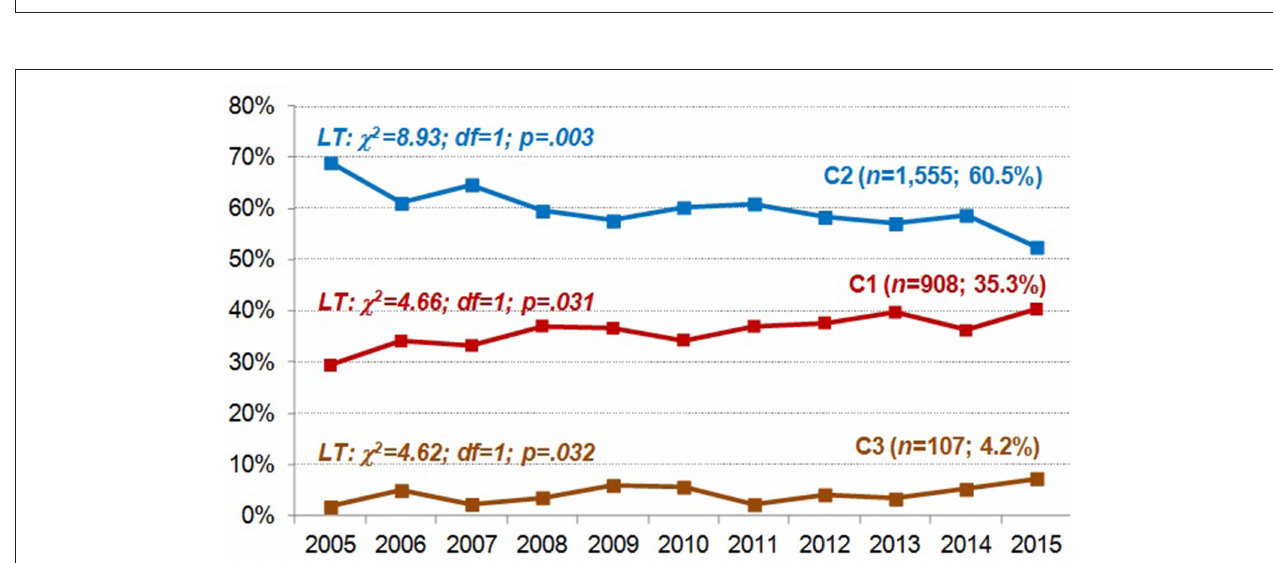
FIGURE 2 | Distribution of the prevalence of each cluster during the data recruitment. LT, linear trend.